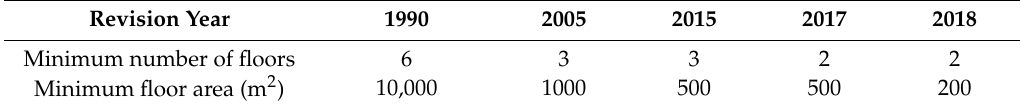
Table 1. Seismic design regulations by year in South Korea. For example, buildings with two or more stories or areas larger than 200 m 2 have had to be constructed with seismic designs since